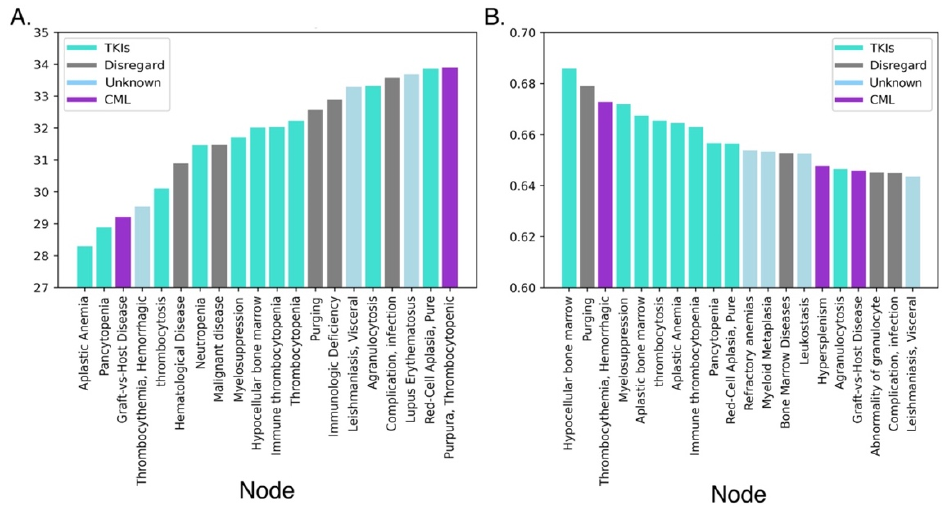
Figure 6. Top twenty Unified Medical Language System (UMLS) nodes related to TKIs and CML. SemNet queried a knowledge graph containing 30+ million journal articles. All nodes shown are of UMLS node type “disease or syndrome” (DSYN). CML and tyrosine kinase were set as SemNet target nodes. Aqua bars correspond to conditions observed in patients on TKIs; purple bars correspond to conditions observed in CML patients on no treatment or on a non-TKI treatment; light blue bars correspond to conditions where no established relationship to CML was found; gray bars correspond to disregarded conditions that were too broad to be informative. ( A ) The top 20 most relevant UMLS node relationships to CML or TKIs based on HeteSim feature relevance. Here, a lower HeteSim score ( y -axis) correlates to a stronger relationship to the target; thus, from left to right, the strengths of the relationships to the target(s) decrease. ( B ) The top 20 relevant UMLS node relationship to CML or TKIs based on novelty score feature relevance. A higher novelty score correlates to a potentially stronger novel connection (meaning fewer studies have published the relationship, although the algorithm still considers the relationship to be relevant to the target nodes). Novelty decreases from left to